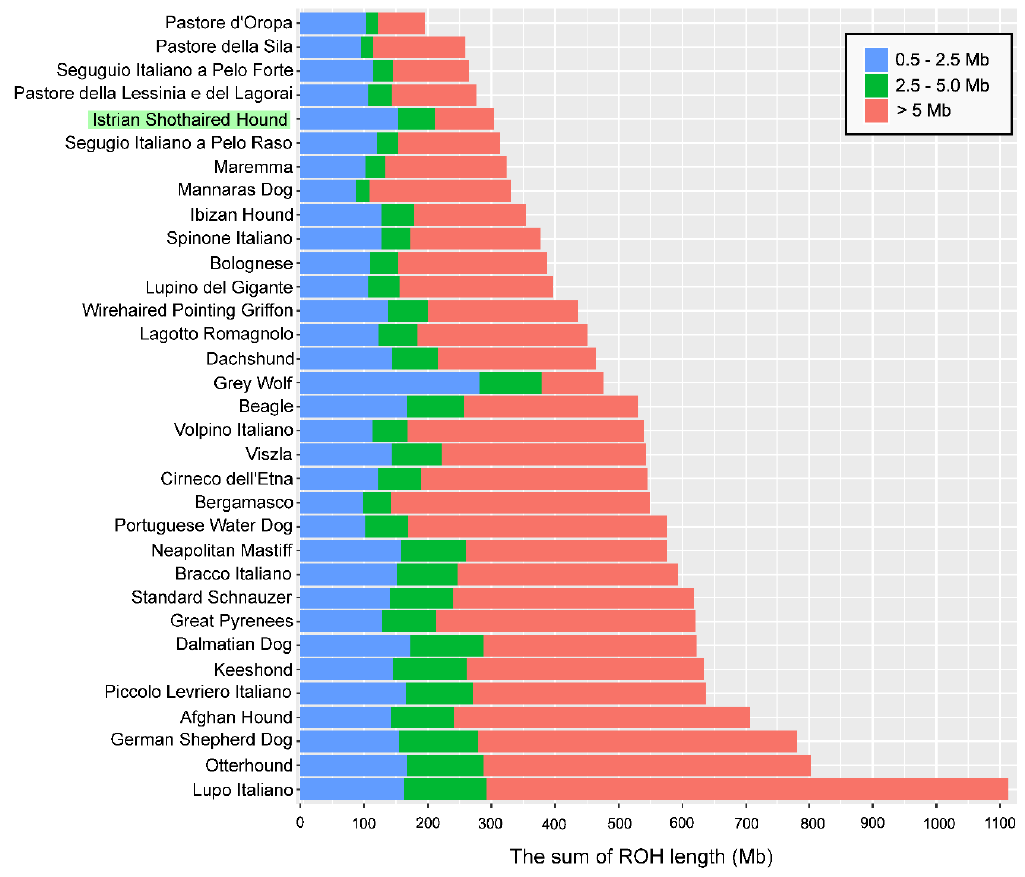
Figure 3. Average sum of ROH for the Istrian shorthaired hound, Grey wolf, and other 31 representative dog breeds. Blue: short (0.5 Mb ≤ ROH < 2.5 Mb), green: medium (2.5 Mb ≤ ROH < 5 Mb), and red: long (ROH > 5 Mb) ROH per breed.